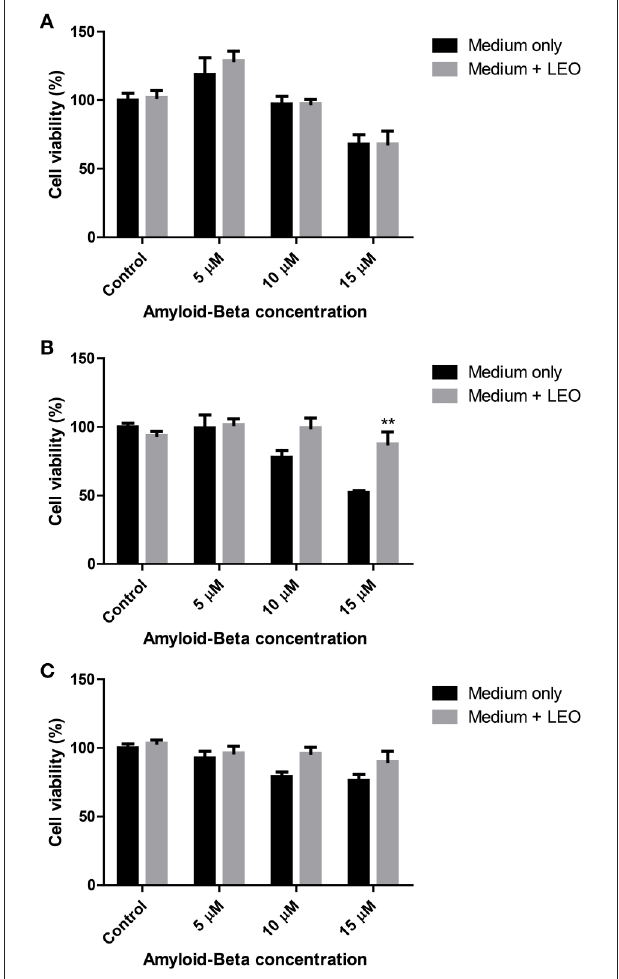
FIGURE 5 | Effect of 1 µ l/ml lavender essential oil (LEO) on beta-amyloid induced toxicity on SH-SY5Y cells at 0 (A) , 2 (B) , and 24h (C) . ** p < 0.01 vs. 15 µ M beta-amyloid (medium